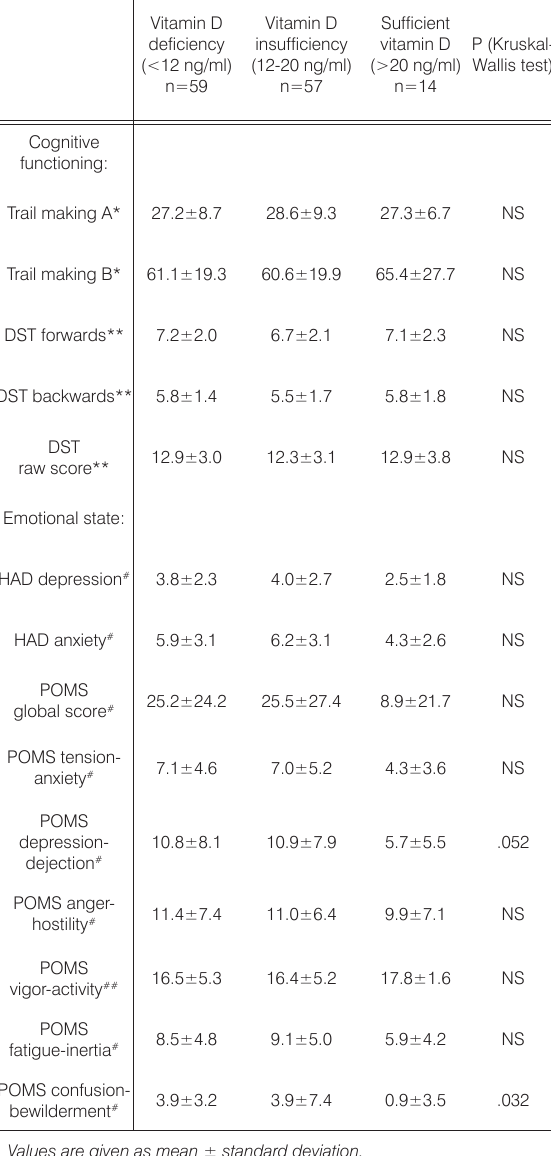
Table 4 Cognitive functioning and emotional state in different subgroups by vitamin D concentration in all